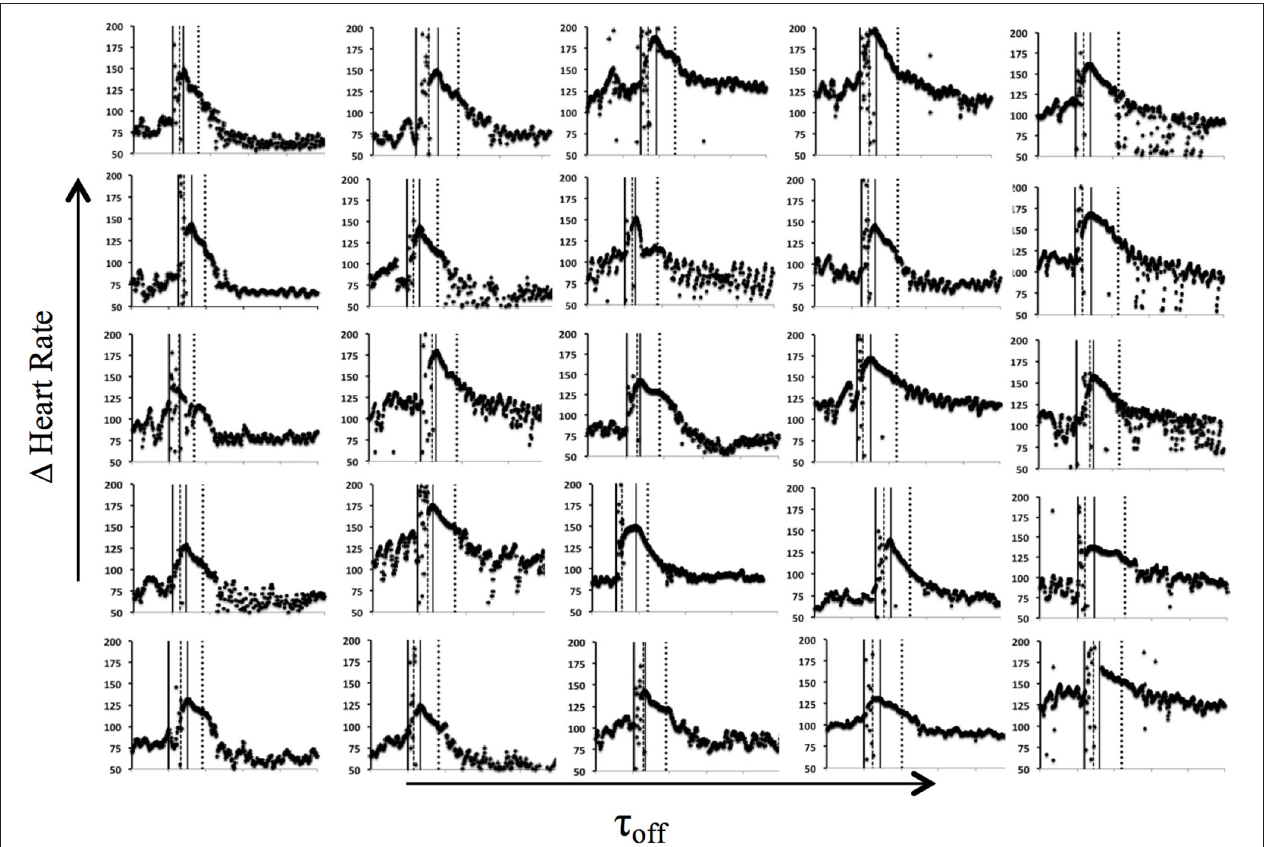
FIGURE 5 | Heart rate recording of each participant ( n = 25) during the sprint test and their respective markers: thick black vertical line as start of the sprint, dashed vertical line representing end of the sprint, thin vertical black line denotes the start decay of HR, and dotted line expresses the τ off